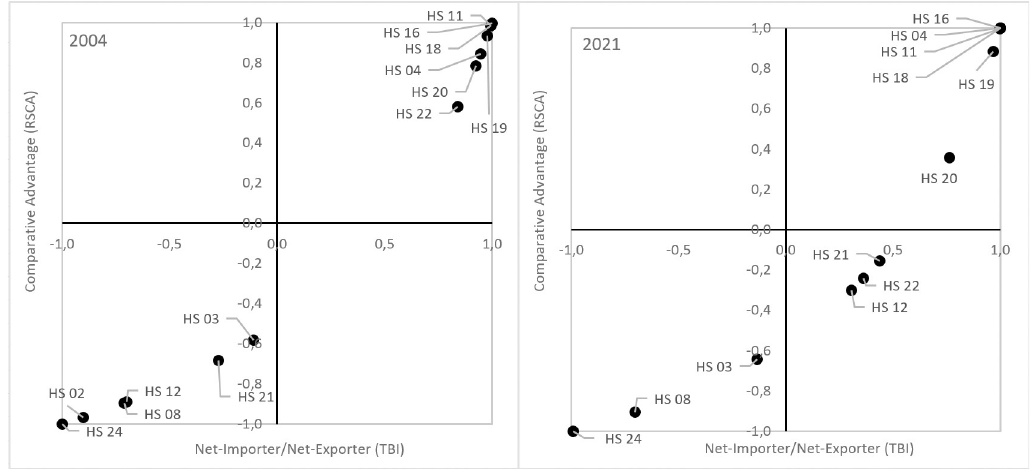
Fig 10. Products mapping for selected agri-food product groups exported from Poland to the USA in 2004 and 2021 (Widodo’s method). Source: [13], the authors’